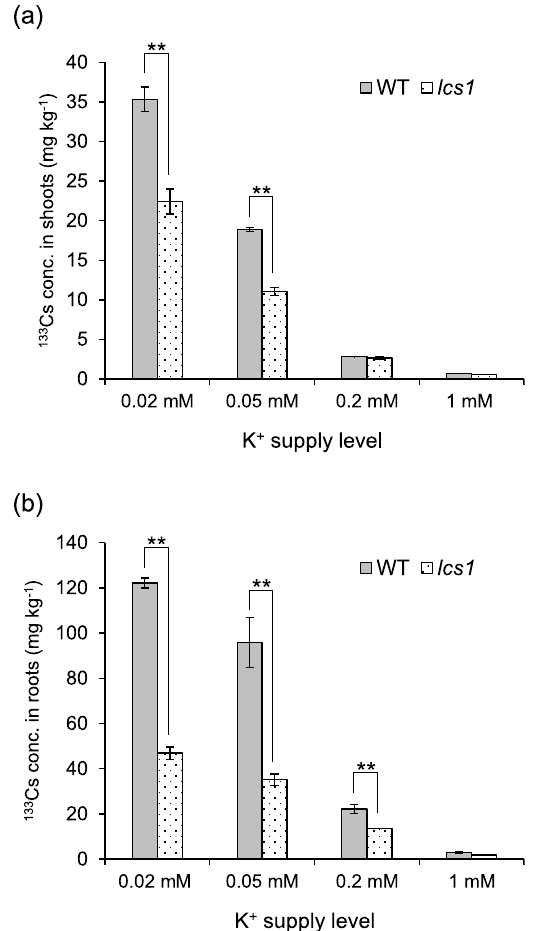
Figure 5. Effects of varying K + levels on 133 Cs concentrations in ( a ) shoots and ( b ) roots of WT and lcs1 . Plants were treated with nutrient solution containing 0.1 µ M Cs + in the presence of 10 mM Na + and varying levels of K + for 6 days. Data are means ± SD of three biological replicates. ** P < 0.01 ( t